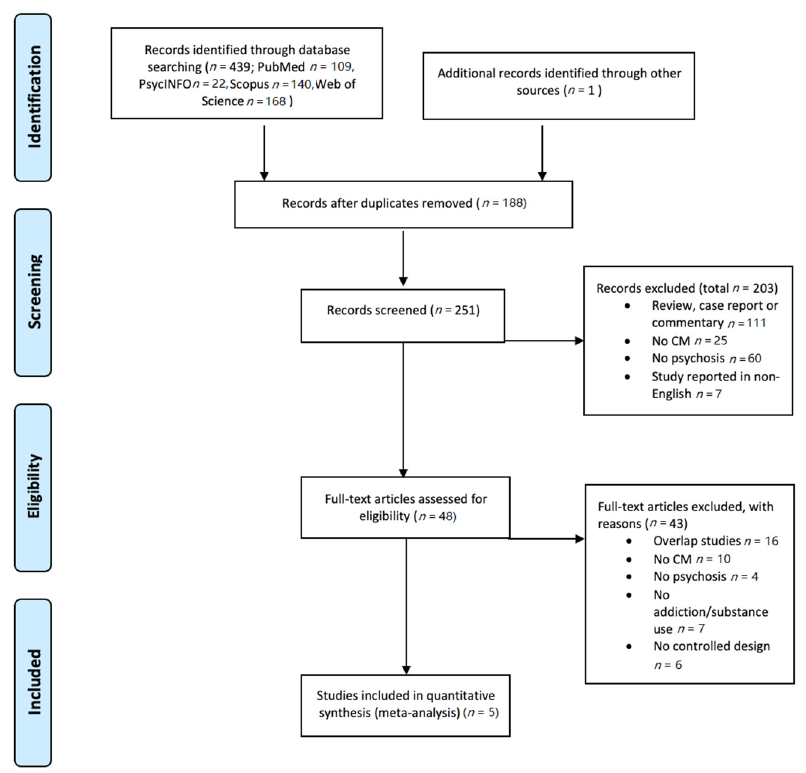
Figure 1. PRISMA flowchart of the selection of studies. CM: contingency management. The effectiveness of CM was calculated by (1) standardized means and standard deviations for each individual study by self-reported number of days of drug, alcohol or nicotine use in the previous 30 days and by (2) the proportion of biochemically verified negative samples. These substance use measures were primary outcome Table 1. The level of risk of bias by the revised risk-of-bias tool (RoB2).